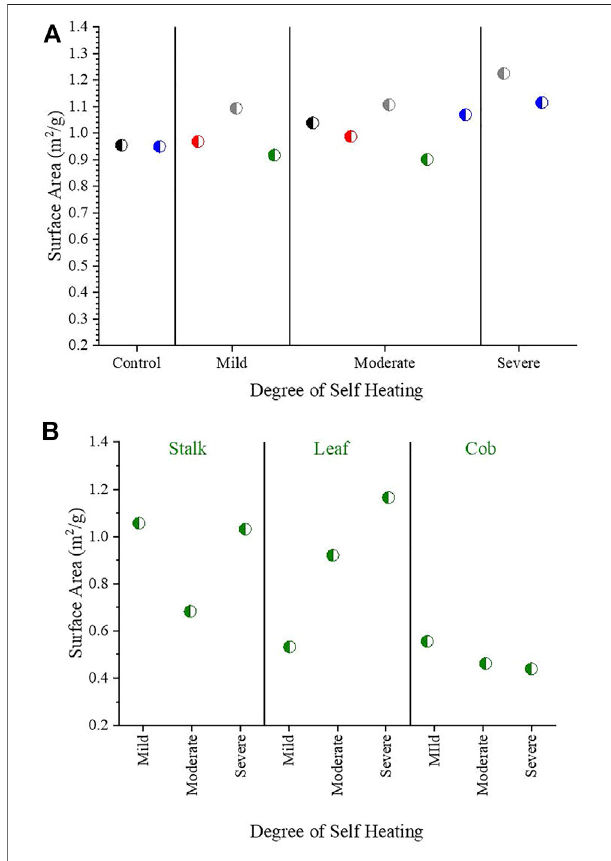
FIGURE3|(A) Surfaceareasofcornstoversamples; H Bale1, H Bale 2, H Bale3, H Bale5, H Bale6. (B) Surfaceareasoffractionatedcornstover samples from Bale